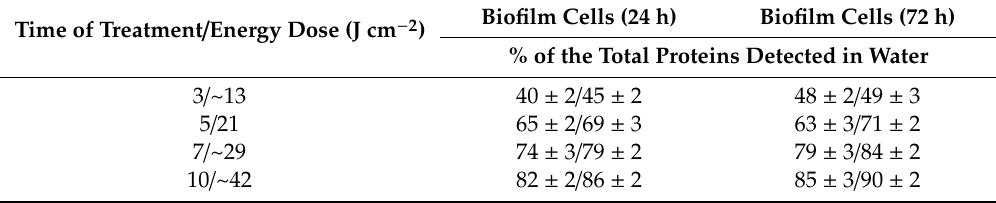
Table 1. The protein released from PA / CA membranes into the water after the nonthermal plasma treatment